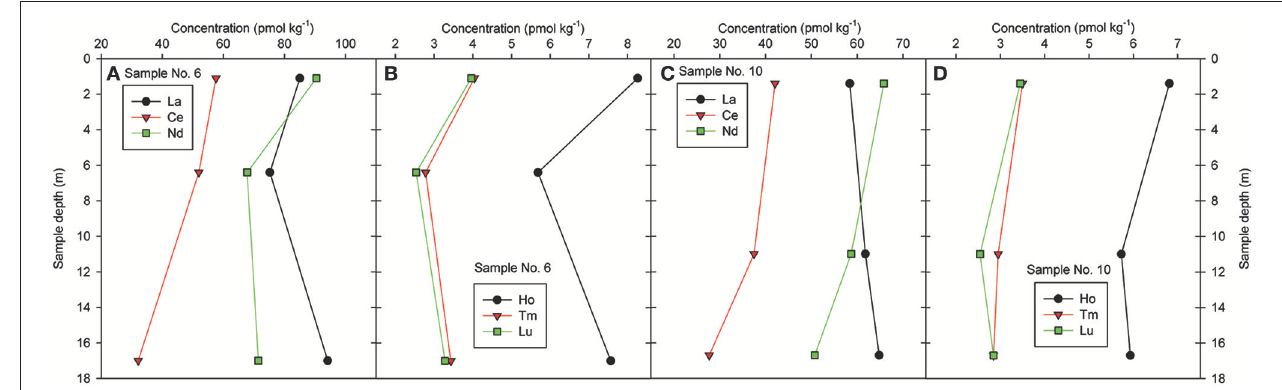
FIGURE 7 | Depth profiles of REE concentrations for samples No. 6 and 10 in the Louisiana Bight (details in Table 1 ) for selected REE, (A,C) LREE: La, Ce, Nd, and (B,D) HREE: Ho, Tm,